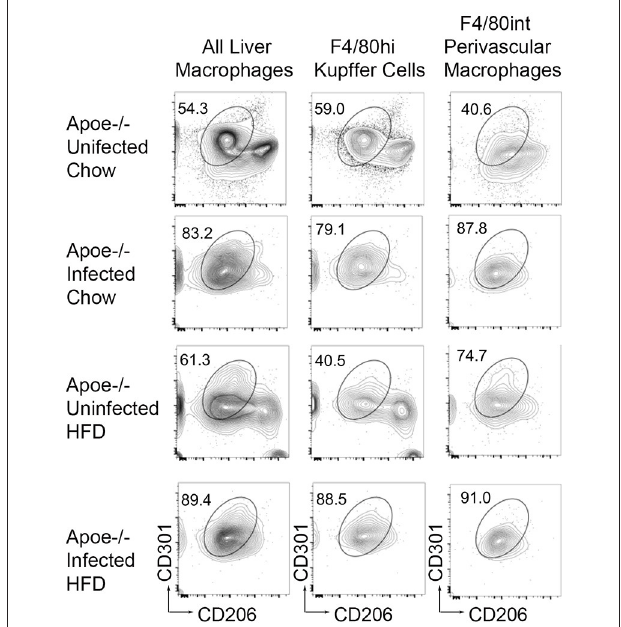
FIGURE 4 | S. mansoni infection induces alternative macrophage activation even in the presence of high fat diet. ApoE − / − male mice were fed HFD or standard chow diet for 10 days before infection with S. mansoni . At 10-weeks post infection, mice were sacrificed. Single cell suspension from perfused liver were stained with markers of interest and analyzed by flow cytometry using the macrophage gating strategy depicted in Figure 1 . Data are concatenated from 5 to 9 mice per group and representative of four independent